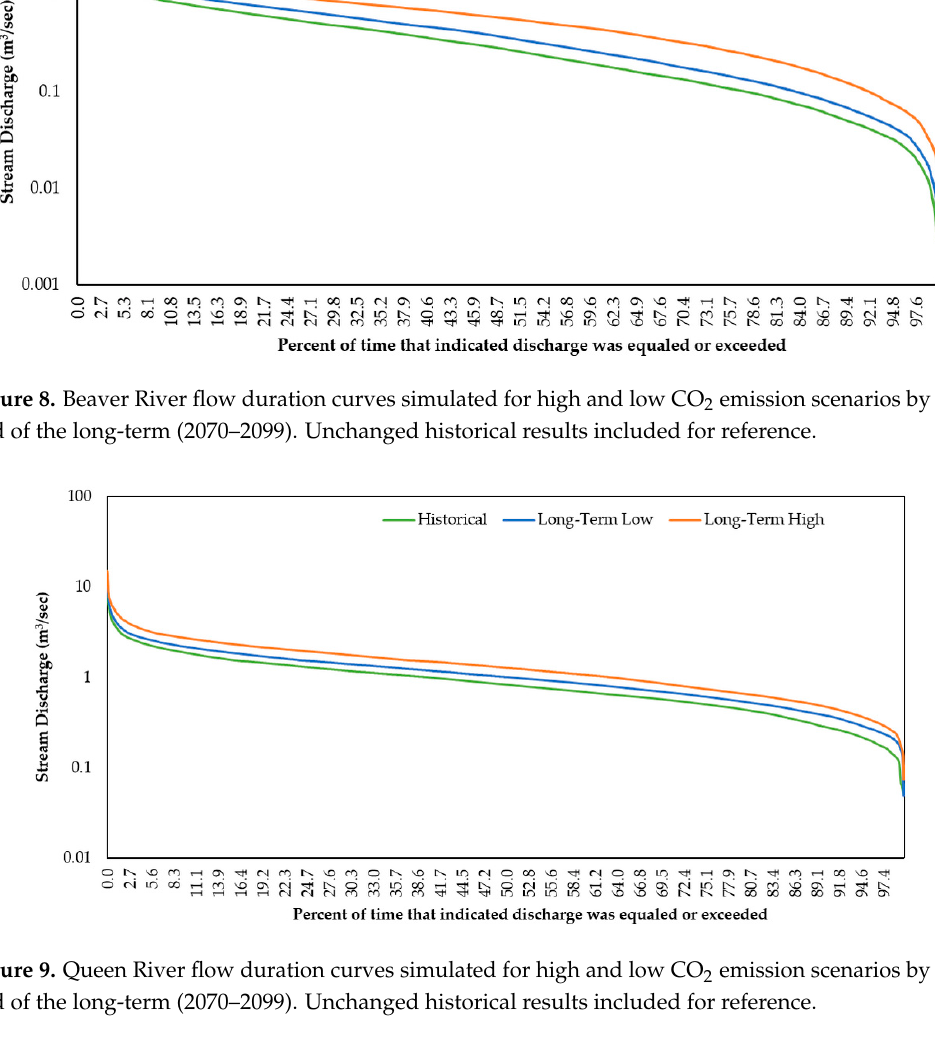
the end of the long-term (2070–2099). Unchanged historical results included for reference.